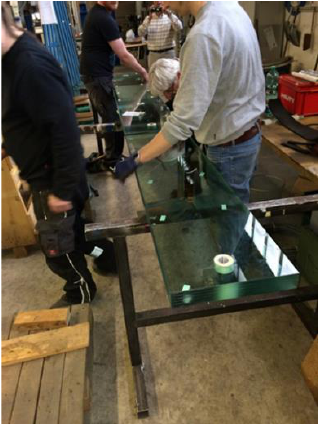
Fig. 8 Glass fin splice testing.